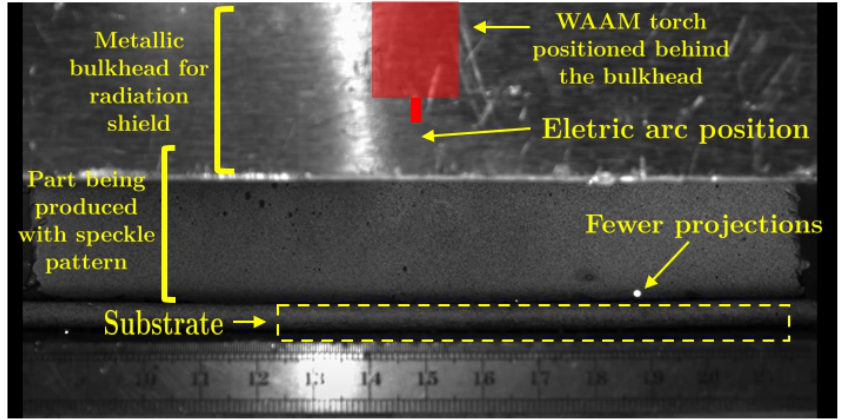
Figure 7. Acquired original image of the WAAM process for DIC purposes. In this case, a metallic bulkhead was used for radiation shield and to reduce the projections.